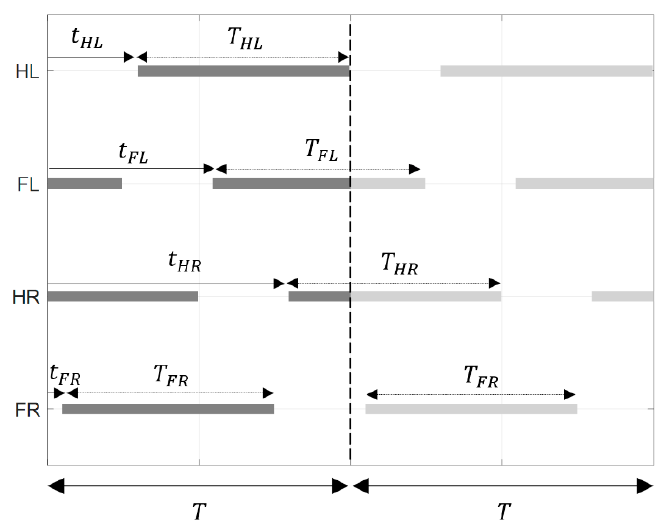
Figure 2. Time diagram of the quadruped’s locomotion over the entire period T shows the times t i at which each leg touches the ground and the time duration T i of each contact phase. The subscripts i = FR , FL , HR , HL are FL (front left), FR (front right), HL (hind left), and HR (hind right).